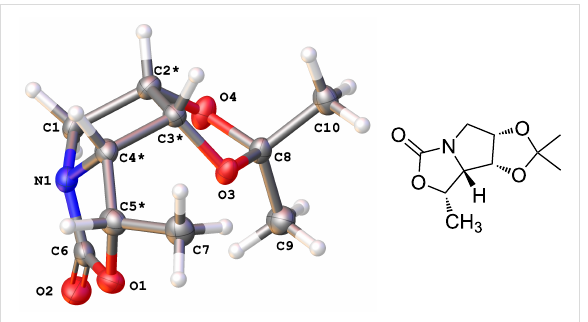
Figure 2: Molecular structure (OLEX2 drawing with adjacent Chem- Draw image) of compound 20 . Atomic displacement ellipsoids are drawn at 50% probability